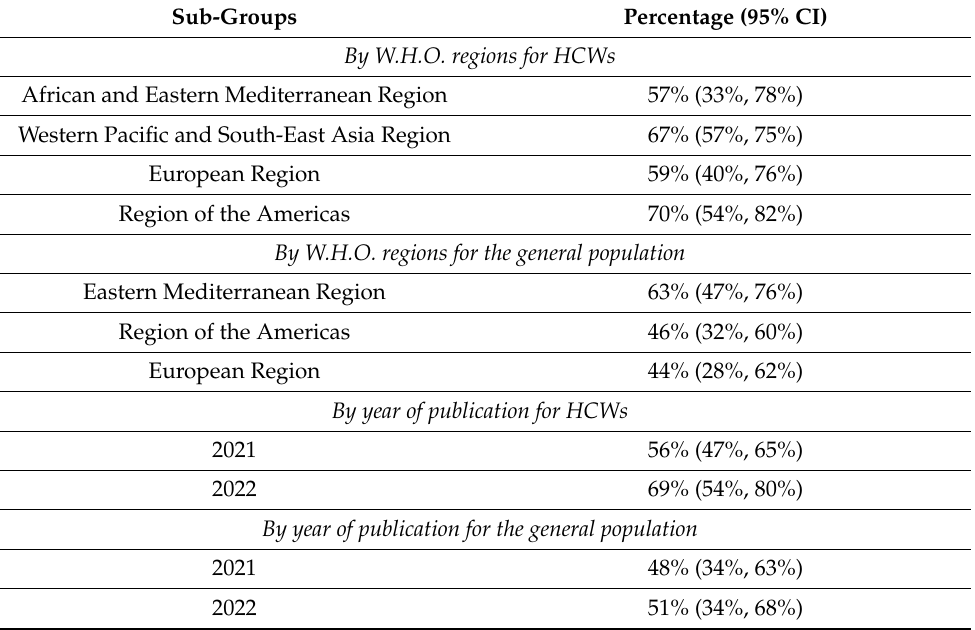
Table 4. Sub-group analyses’ results—HCWs’ acceptance towards COVID-19 Mandatory